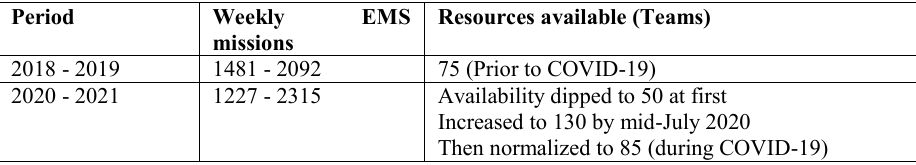
Table 3. Variation of Weekly EMS Missions and Availability of Teams